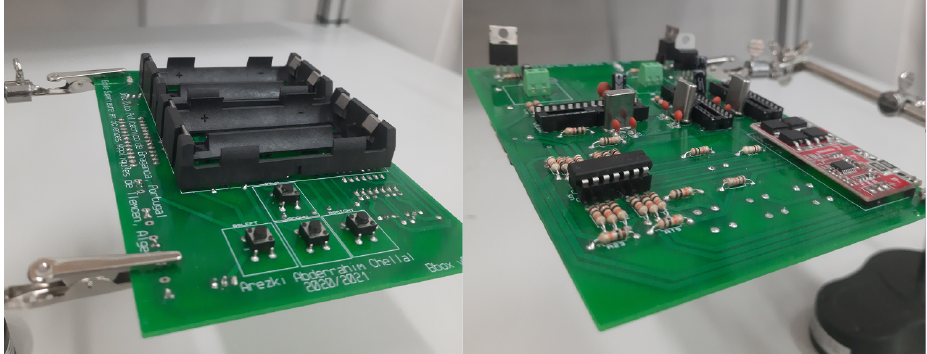
Figure 14. Printed Circuit Board with soldered